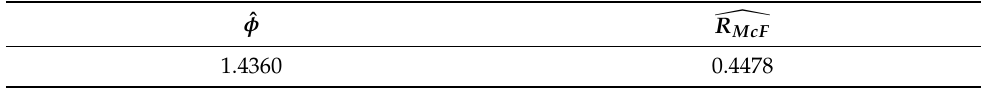
Table 9. Estimates of φ and R McF